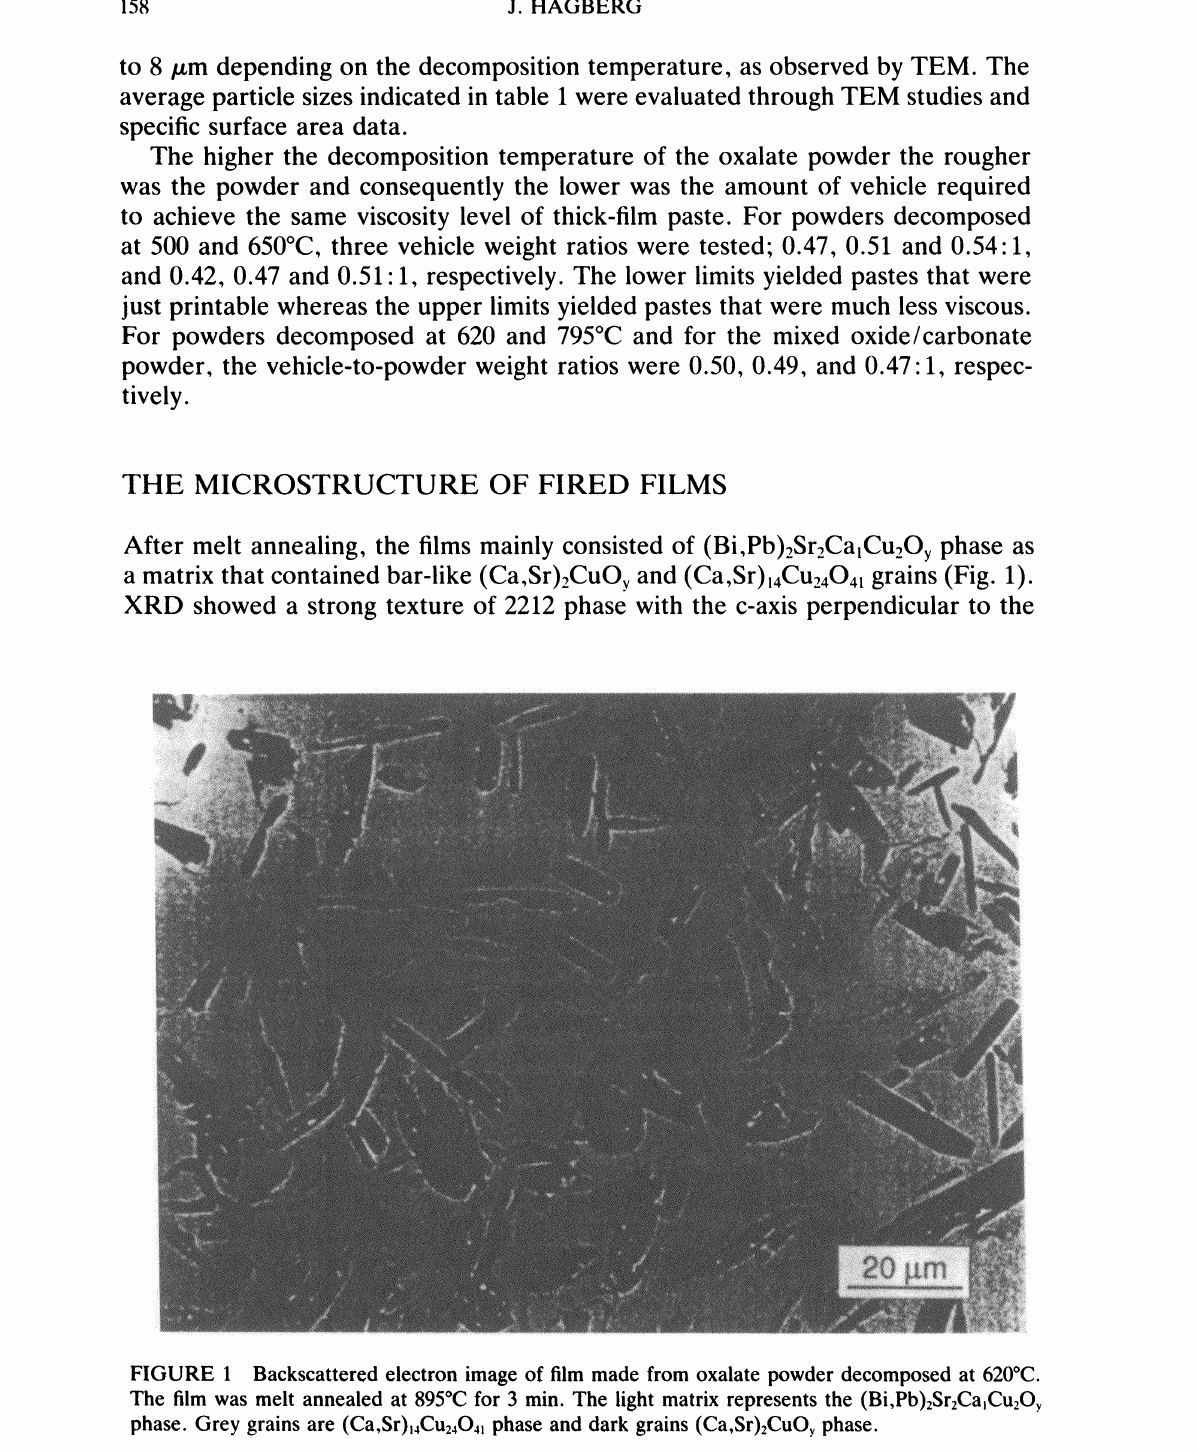
FIGURE Backscattered electron image of film made from oxalate powder decomposed at 620C. The film was melt annealed at 895C for 3 min. The light matrix represents the (Bi,Pb)2Sr2CaCu2Oy phase. Grey grains are (Ca,Sr)4Cu2404 phase and dark grains (Ca,Sr)2CuOy